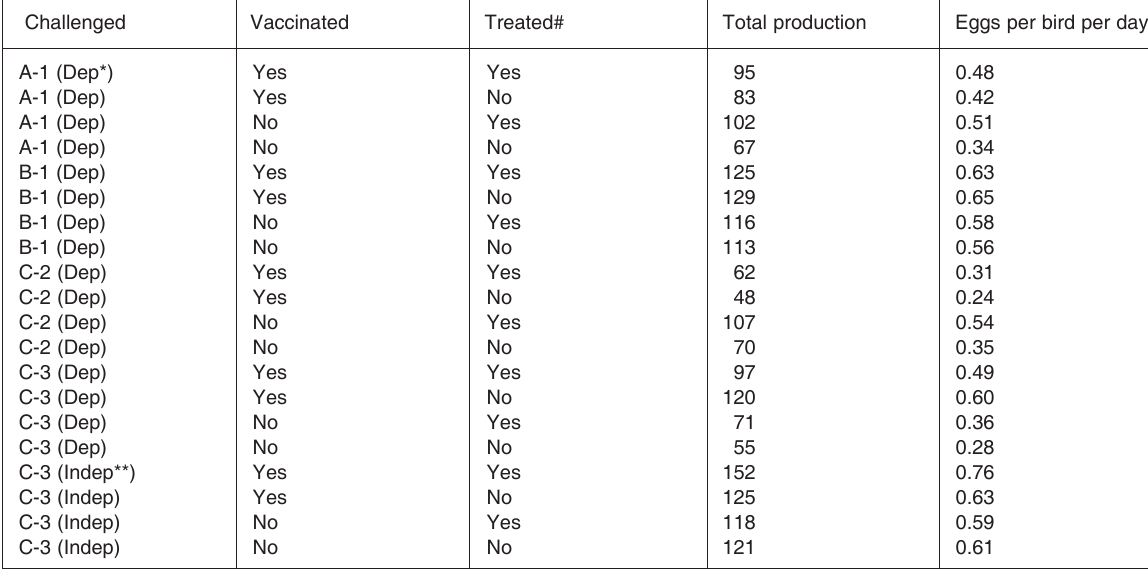
TABLE 2 Daily egg production and the number of eggs per chicken per day for the experimental period Challenged Vaccinated